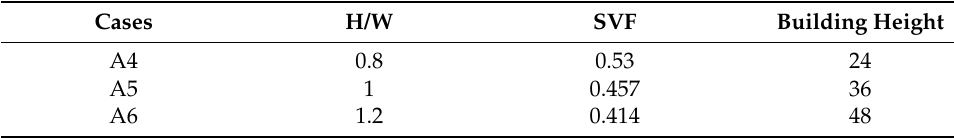
Table 5. Cases for building